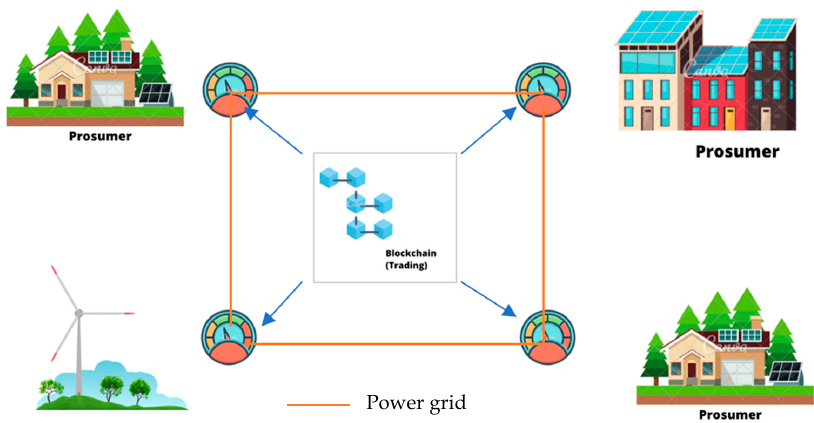
Figure 11. Trading system representation.